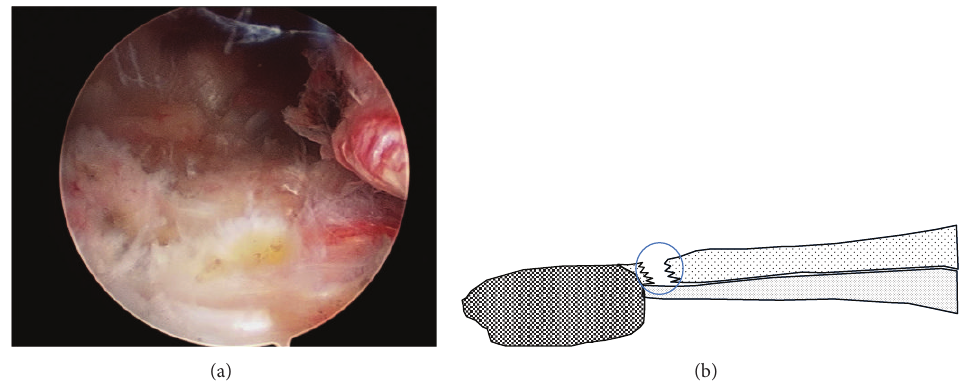
Figure 11: Arthroscopic view and schema from the lateral suprapatellar portal in the left knee. (a) The free space between the superior rim of the patella (left) and the torn tendon (right) was caused by the disruption of the superficial layer by the quadriceps tendon rupture. The intact deep layer is visible on the lower side. (b) The schema of (a).